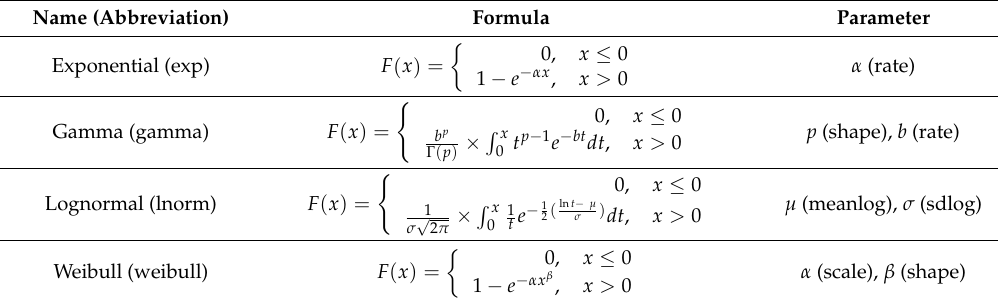
Table 2. Theoretical distribution functions.